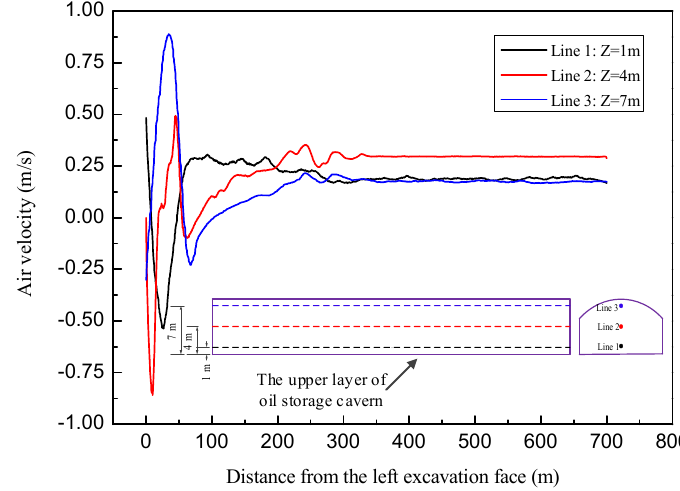
Figure 9. Air velocity distribution along the cavern.